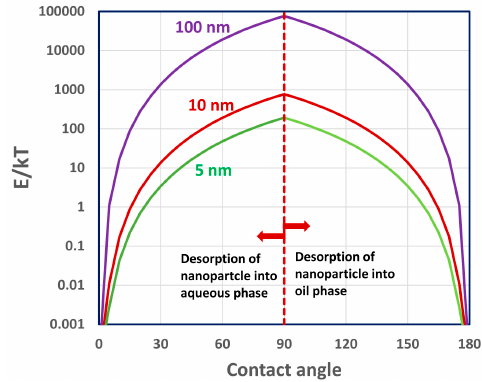
Figure 3. Relative desorption energy of a single solid nanoparticle as a function of contact angle θ for different values of nanoparticle radius.